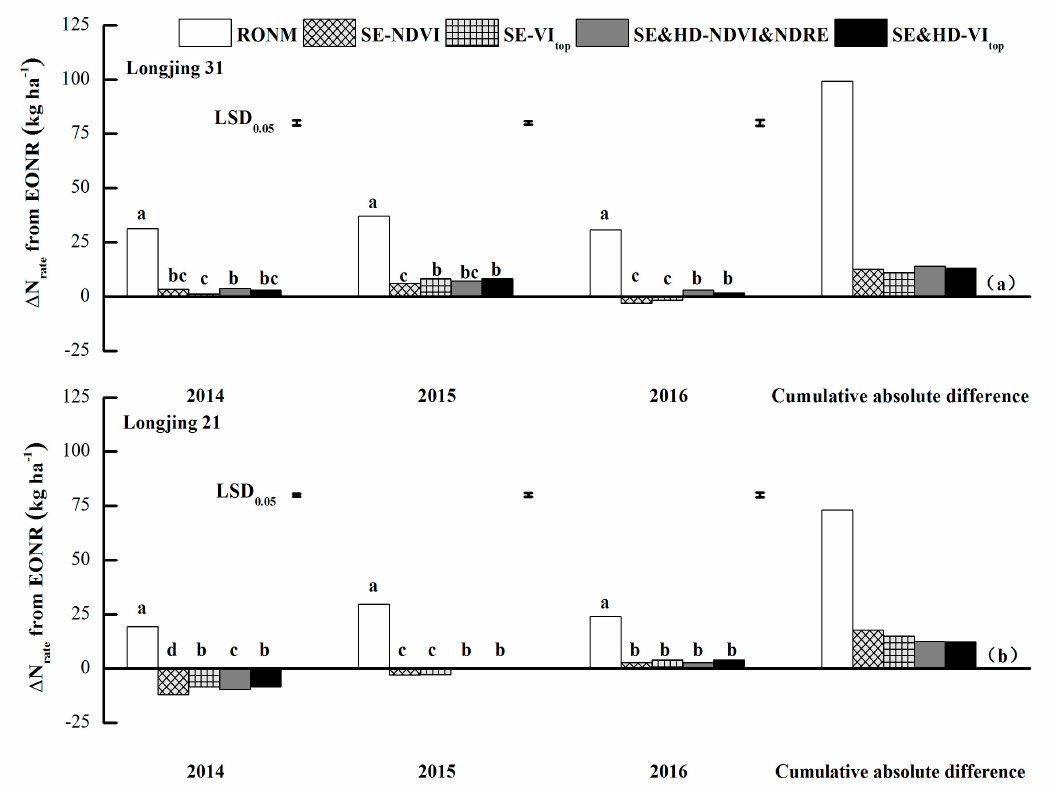
Figure 8. The di ff erence of recommended N topdressing application rate ( ∆ N rate ) from economically optimal N rates (EONR) between RONM strategy and RapidSCAN sensor-based PNM strategies for the rice varieties of Longjing 31 ( a ) and Longjing 21 ( b ) under surplus N status before topdressing (N160) in 2014–2016. RONM: the regional optimum N management topdressing N rate (36 kg N ha − 1 in this study). SE-NDVI and SE-VI top indicated recommended topdressing N application rates calculated by the models using NDVI and the top performing VIs (VI top ) for di ff erent varieties at stem elongation stage, respectively. SE&HD-NDVI&NDRE and SE&HD-VI top indicated recommended topdressing N application rates calculated by the models using NDVI (at stem elongation stage) and NDRE (at heading stage), and VI top at stem elongation and heading stage, respectively. Vertical bars represent the LSD value ( p = 0.05). Di ff erent letters indicate significant di ff erence at p < 0.05 level within the same year.